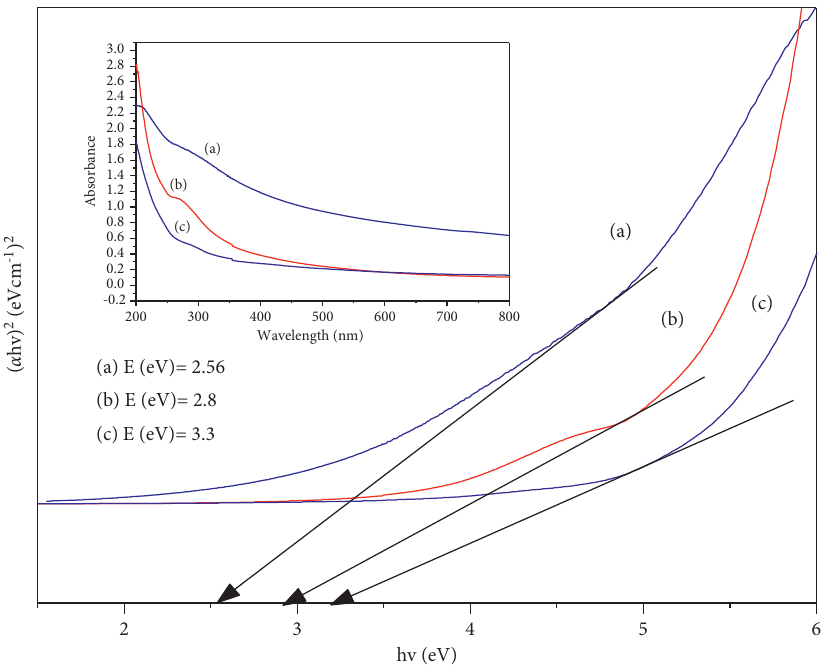
Figure 6: Bandgap energy estimation of (a) Fe-CN/AW, (b) Fe-CN, and (c) CN-AW by the Tauc plot